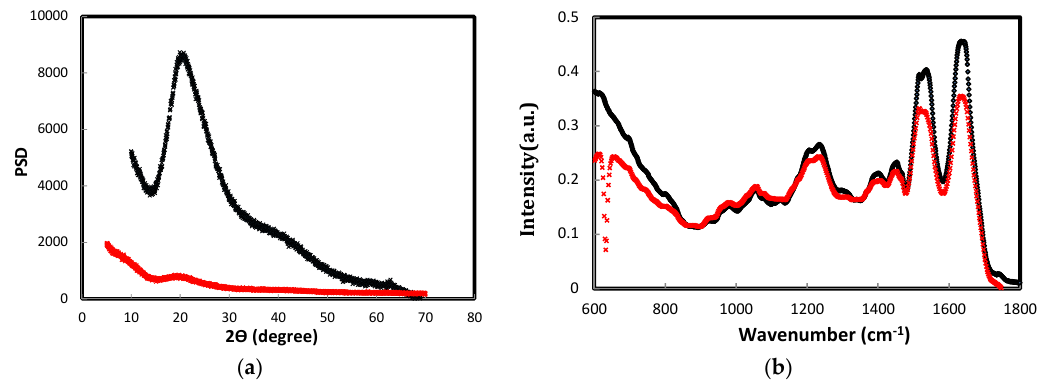
Figure 4. ( a ) X ‐ ray powder diffraction of keratin films; PSD stands for power spectral density of any signal. ( b ) FTIR (Fourier transform infrared spectroscopy) of keratin films. The black spectrum was obtained from dialyzed and diafiltered keratin film after 14 cycles of diafiltration; the red plot was obtained from dialyzed keratin film after three days of dialysis.